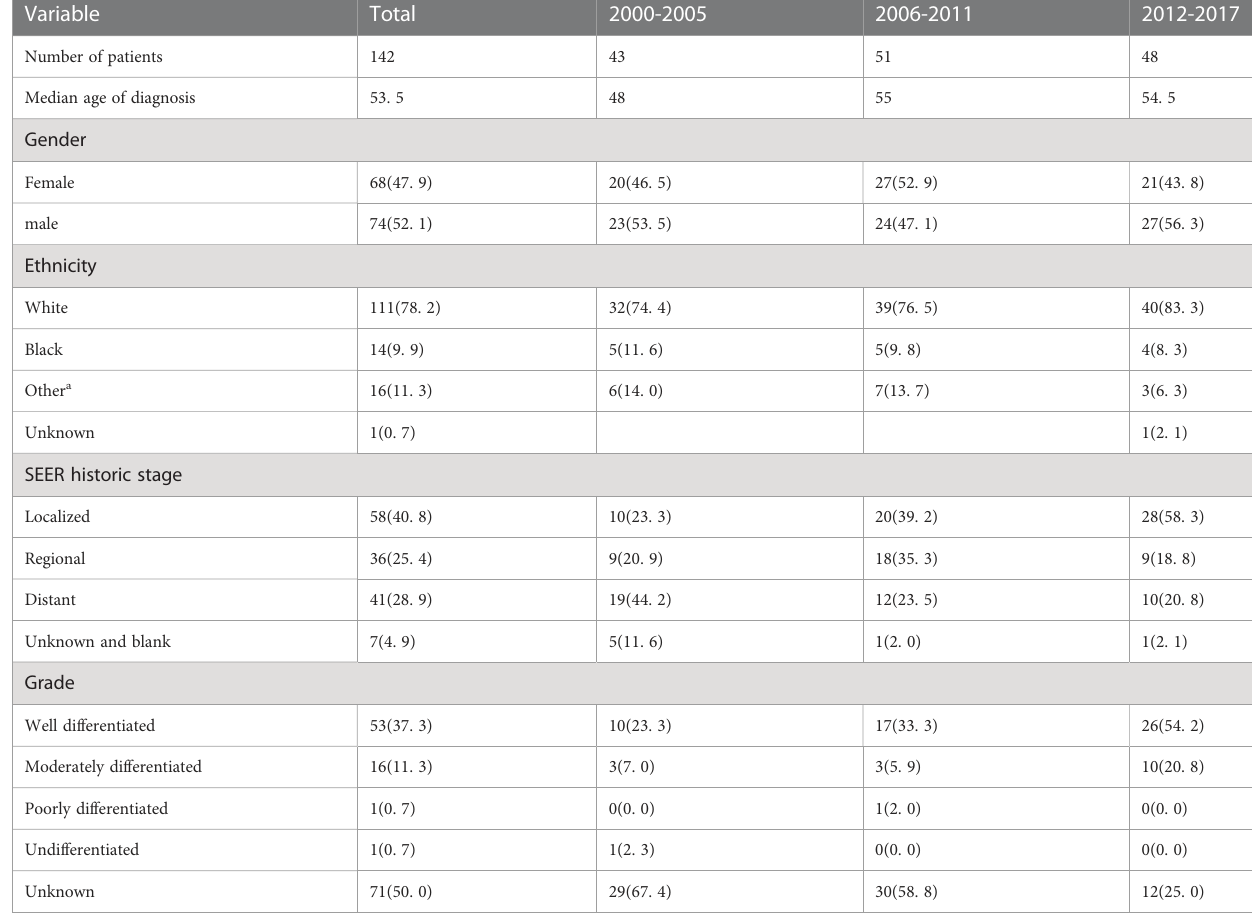
TABLE 1 Demographic and pathological characteristics of the study population (2000 –